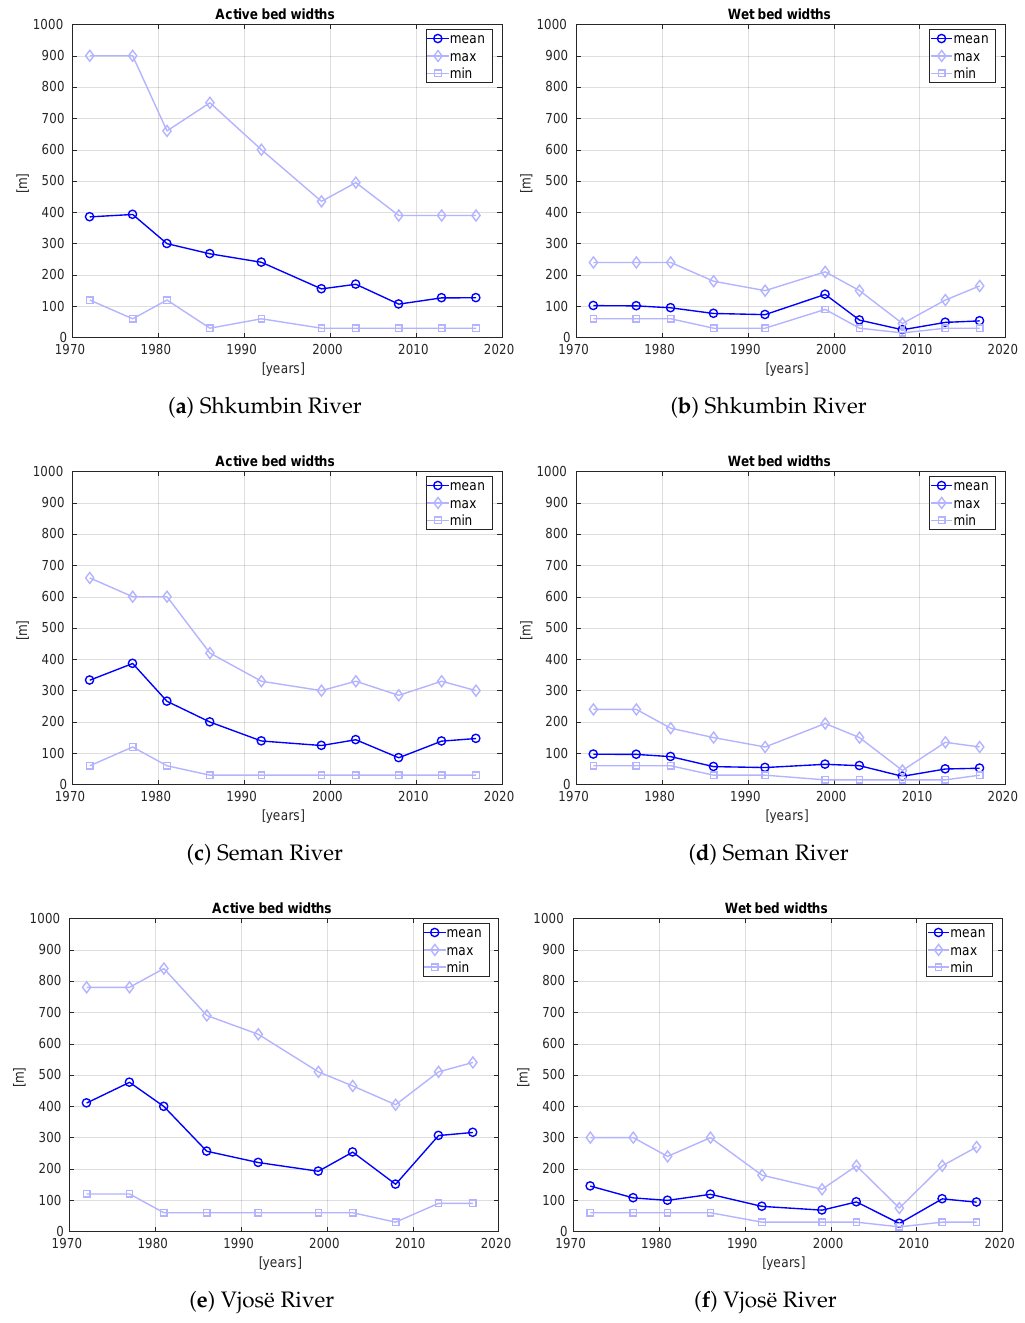
Figure 8. Multi-temporal evolution of the active channel widths ( Left ) and of the wet channel widths ( Right ) for the Shkumbin ( a , b ), Seman ( c , d ) and Vjosë ( e , f )